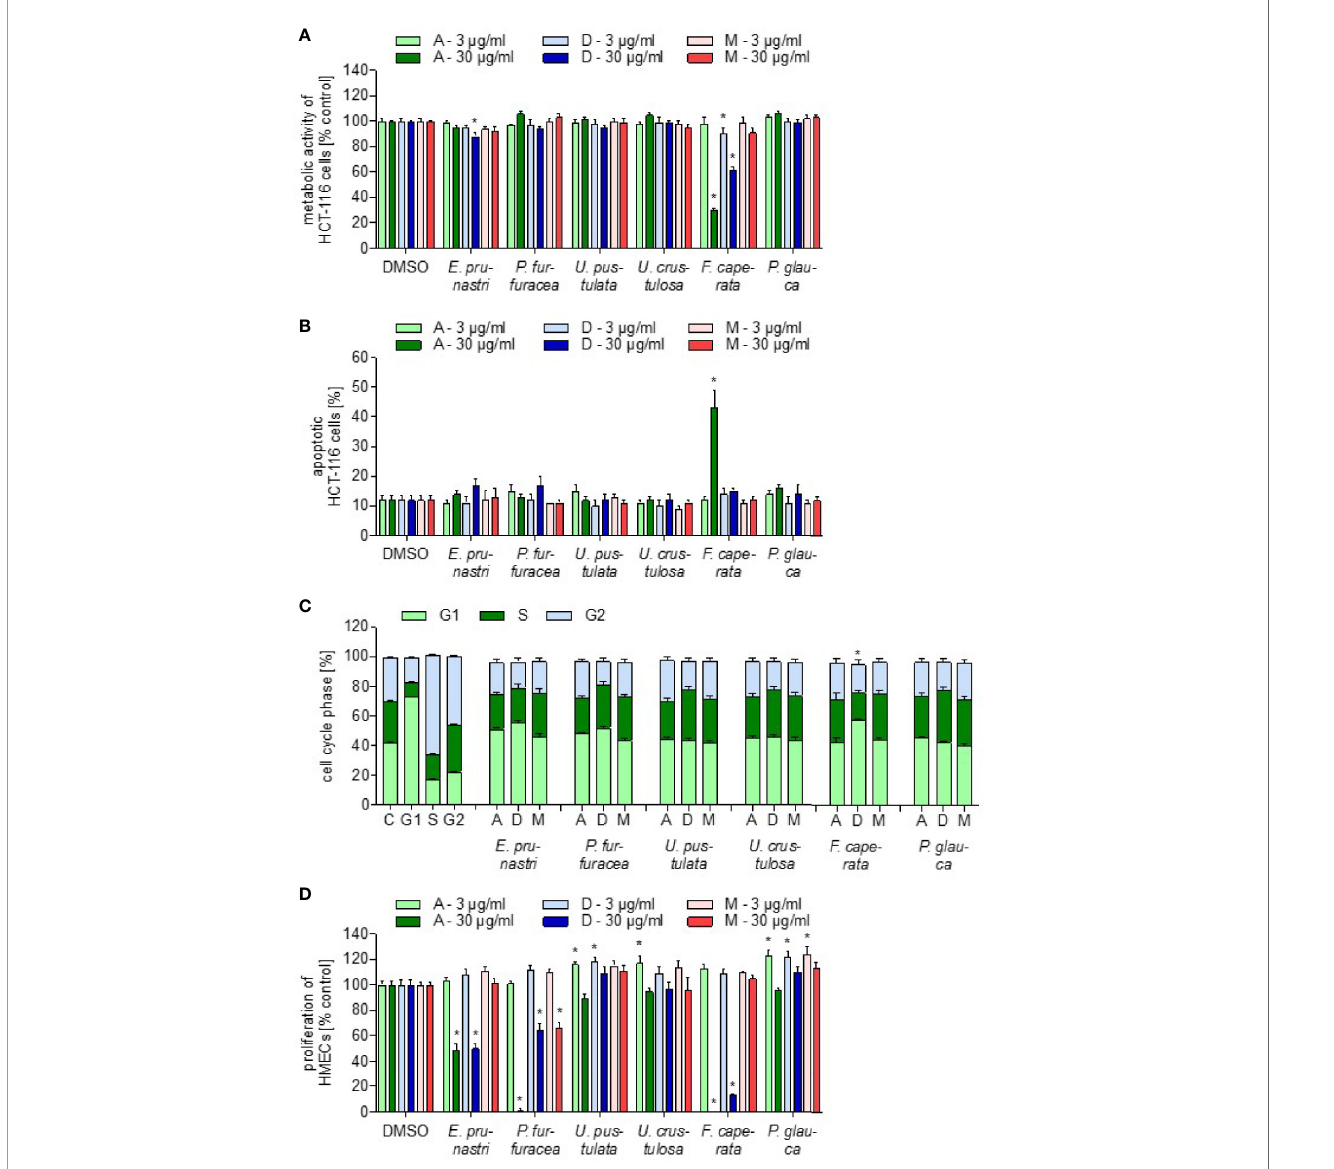
FIGURE 2 | Toxicity characterization of lichen extracts. (A) For the cell viability assay, HCT-116 cells were incubated with 3 or 30 µg/ml lichen extracts or dimethyl sulfoxide (DMSO) (control) for 24 h. WST-1 dye was added for 60 min and the viability was quanti fi ed by detection of formazan. Data are expressed as mean ± SEM. n=2, *p ≤ 0.05 versus control. (B) For the apoptosis assay, HCT-116 cells were incubated with 3 and 30 µg/ml lichen extracts or DMSO (control) for 24 h. Apoptotic cells were stained with a caspase-3-detecting antibody. Data are expressed as mean ± SEM. n=2, *p ≤ 0.05 versus control. (C) For the cell cycle analysis, HCT-116 cells were incubated for 24 h with 30 µg/ml lichen extracts or DMSO (control). Cells were stained with propidium iodide and measured using fl ow cytometry. Data are expressed as mean ± SEM. n=3, *p ≤ 0.05 versus control. Signi fi cances are shown when all three cell cycle phases were signi fi cantly different. (D) For the proliferation assay, HMEC-1 cells were grown in low-density and treated after 24 h with lichen extracts (3 and 30 µg/ml) for 72 h. Cells were stained with crystal violet solution. The amount of DNA-bound crystal violet was detected by absorbance measurements. Data are expressed as mean ± SEM. n=2, *p ≤ 0.05 versus